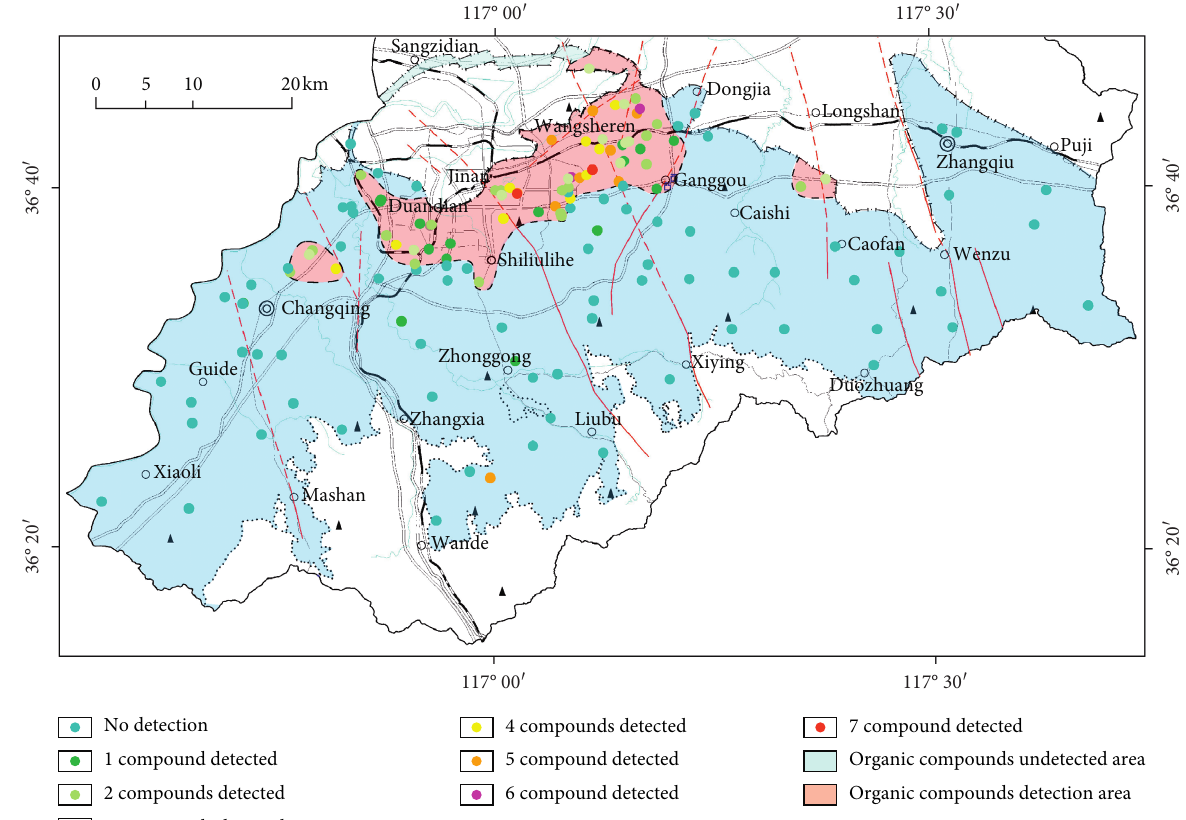
Figure 4: Distribution of the number of toxic organic compounds in fractured karst water.